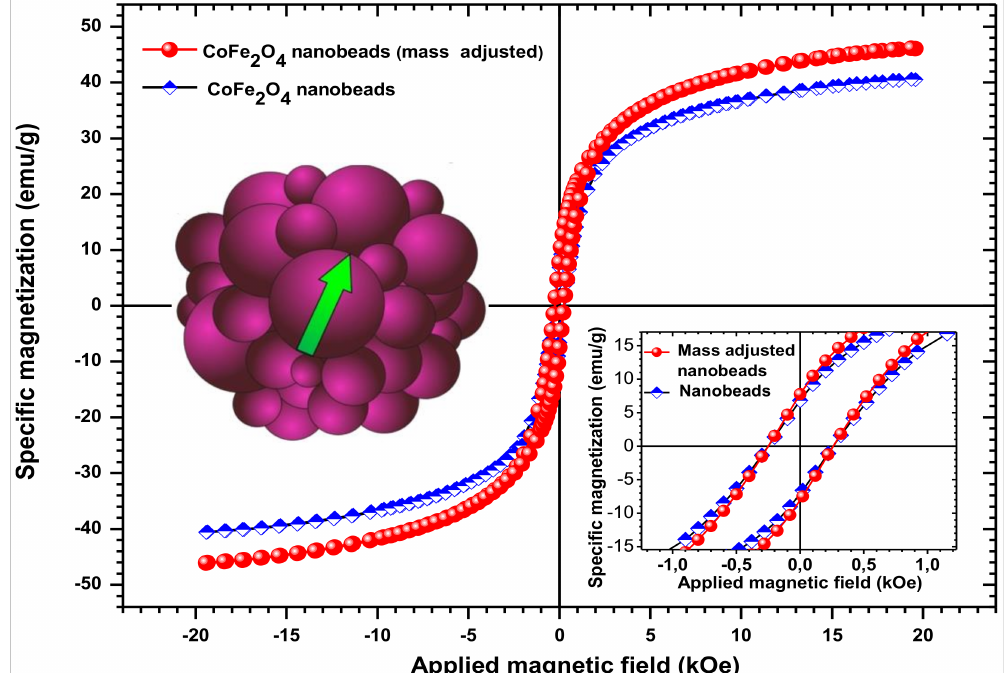
Figure 4. Magnetization loop of the ferrimagnetic CF@CMC nanobeads. Inset: detail from the loop near zero magnetic field. After adjusting for the non-magnetic mass contribution of the copolymer, according to TG/DSC measurements, the specific magnetization of the bare CoFe2O4 nanoparticles becomes 14% higher in comparison with polymer-CoFe 2 O 4